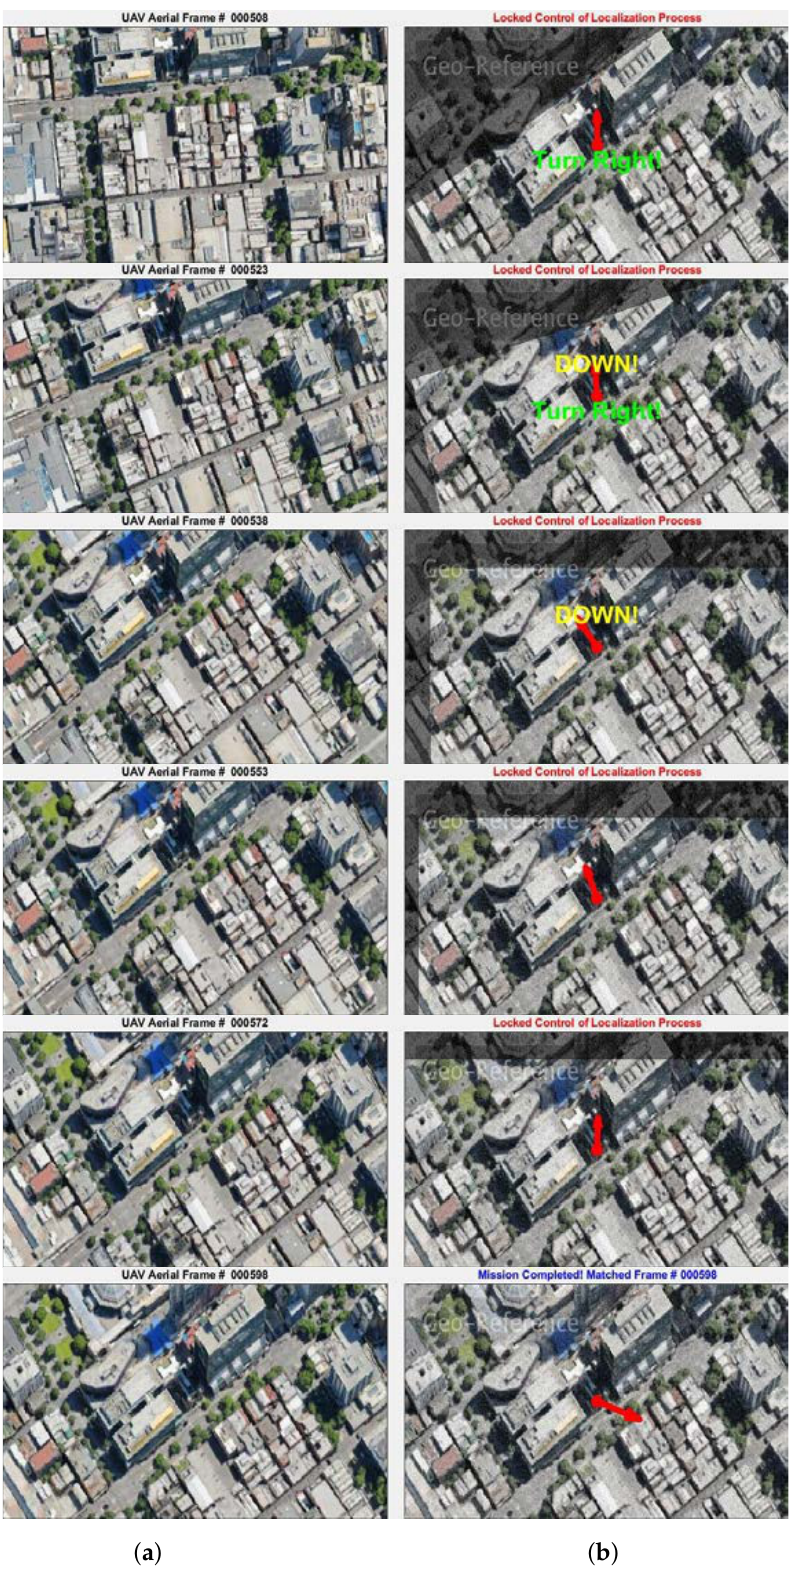
Figure 10. Illustration of a typical UAV locked-up localization process that involves all UAV controls generated by image registration as discussed in Section 3. The entire process takes up about 50 frames. We only show six of those frames. Column ( a ): UAV aerial camera view. Column ( b ): aerial images “registered” on top of georeferenced image. For this particular example, the localization accuracy is within 3 m. The processing frame rate is 5 fps (Intel(R) Core(TM)